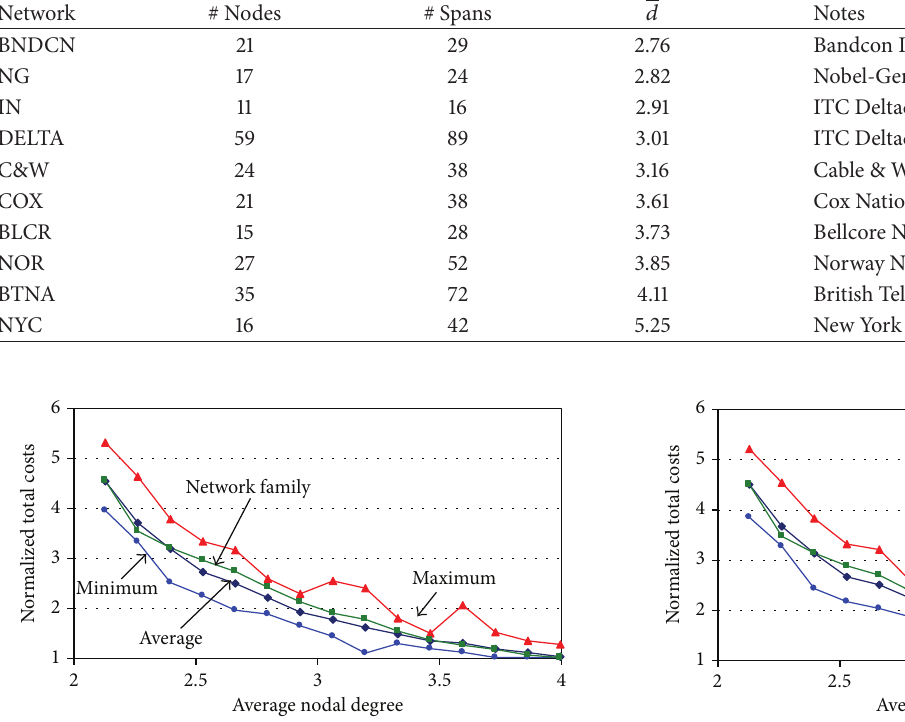
Figure 3: Normalized p -cycle JCA total capacity costs.